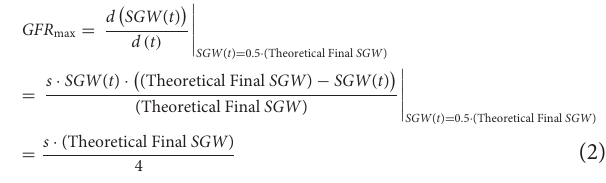
a Based on averages for all genotypes evaluated, with “booting/flowering” defined as the period 10 days before- to 4 days after-awn emergence and “early grain-filling” from 5 to 25 days after awn emergence, respectively. b Irrigated with 40mm at sowing due to the dry season